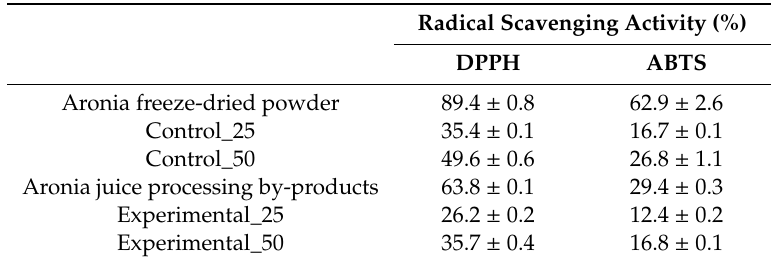
Table 4. Determination of radical scavenging activity of aronia powder and bioelastomers.